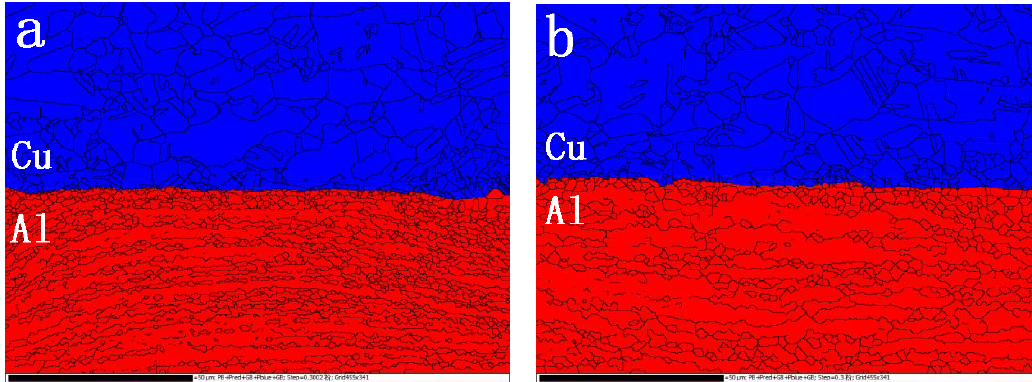
Figure 4. Electron Backscatter Diffraction (EBSD) grain boundary maps of the interface of the Cu/Al laminated composite: ( a ) unpulsed; ( b ) pulse.